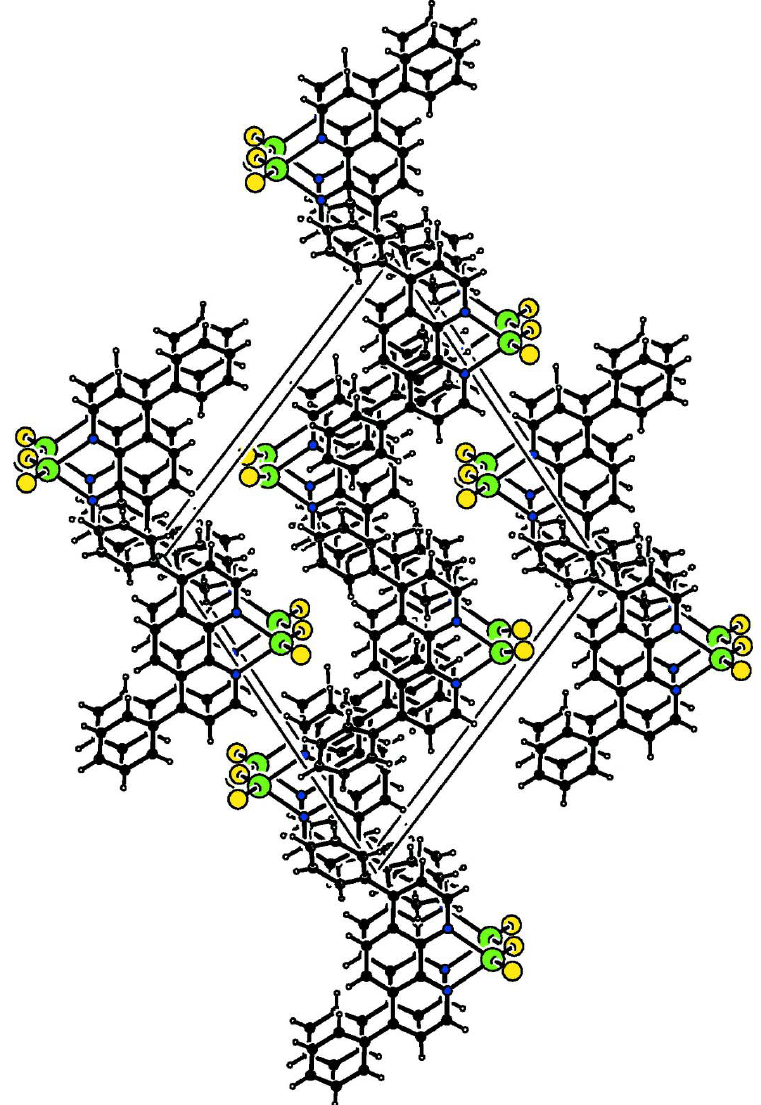
Figure 2 A partial packing diagram of the title